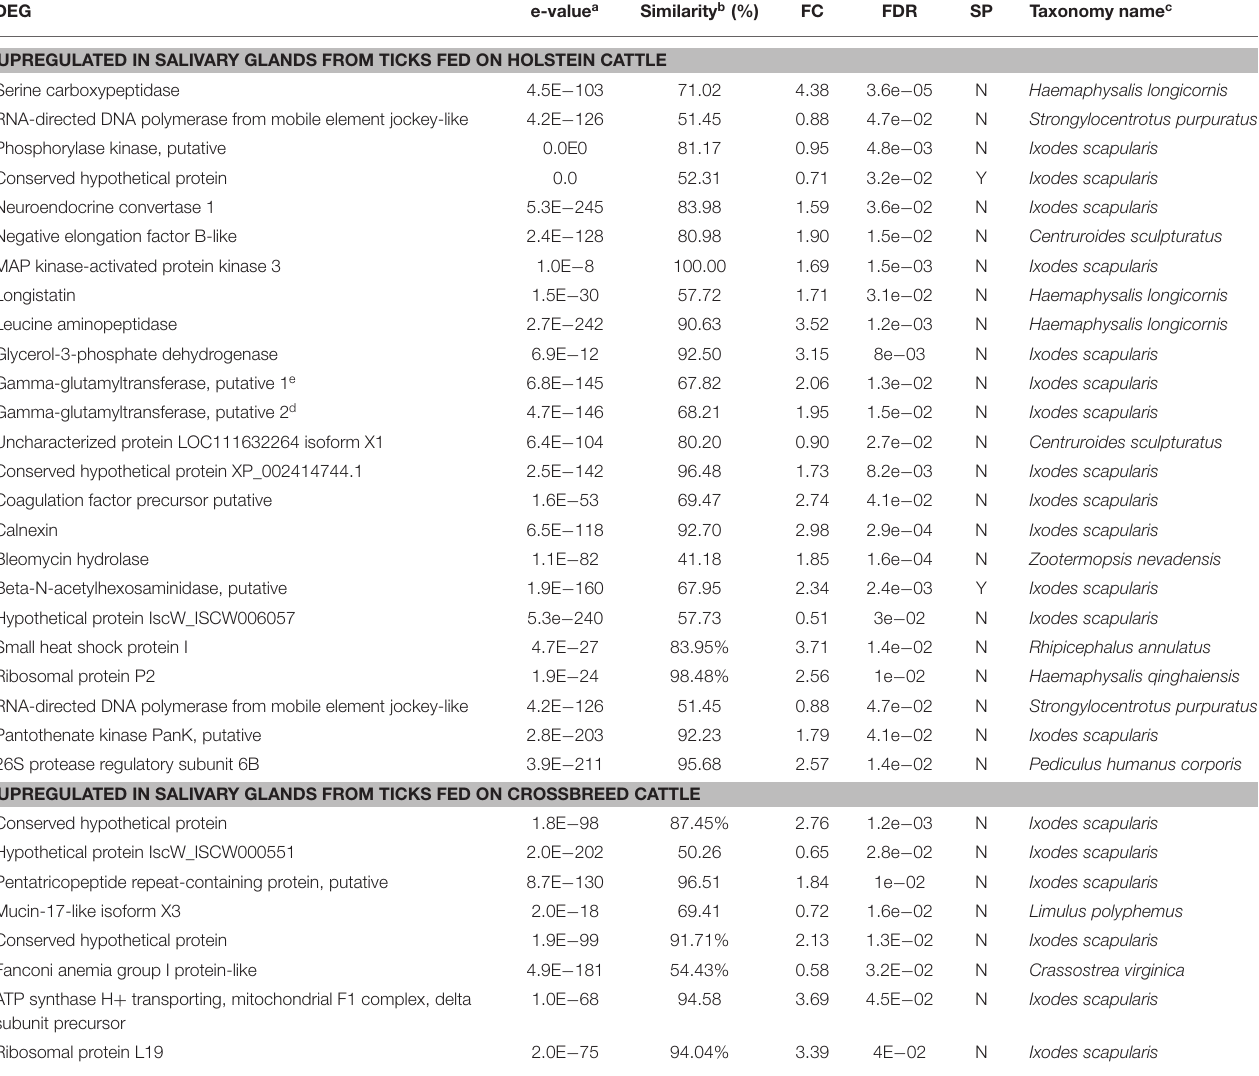
TABLE 2 | Differentially expressed genes (DEG) upregulated in salivary glands from ticks fed on susceptible-tick cattle (Holstein) and ticks fed on resistant-tick cattle (Holstein × Nelore crossbreed) from most represented molecular functions and biological process GO terms. DEG